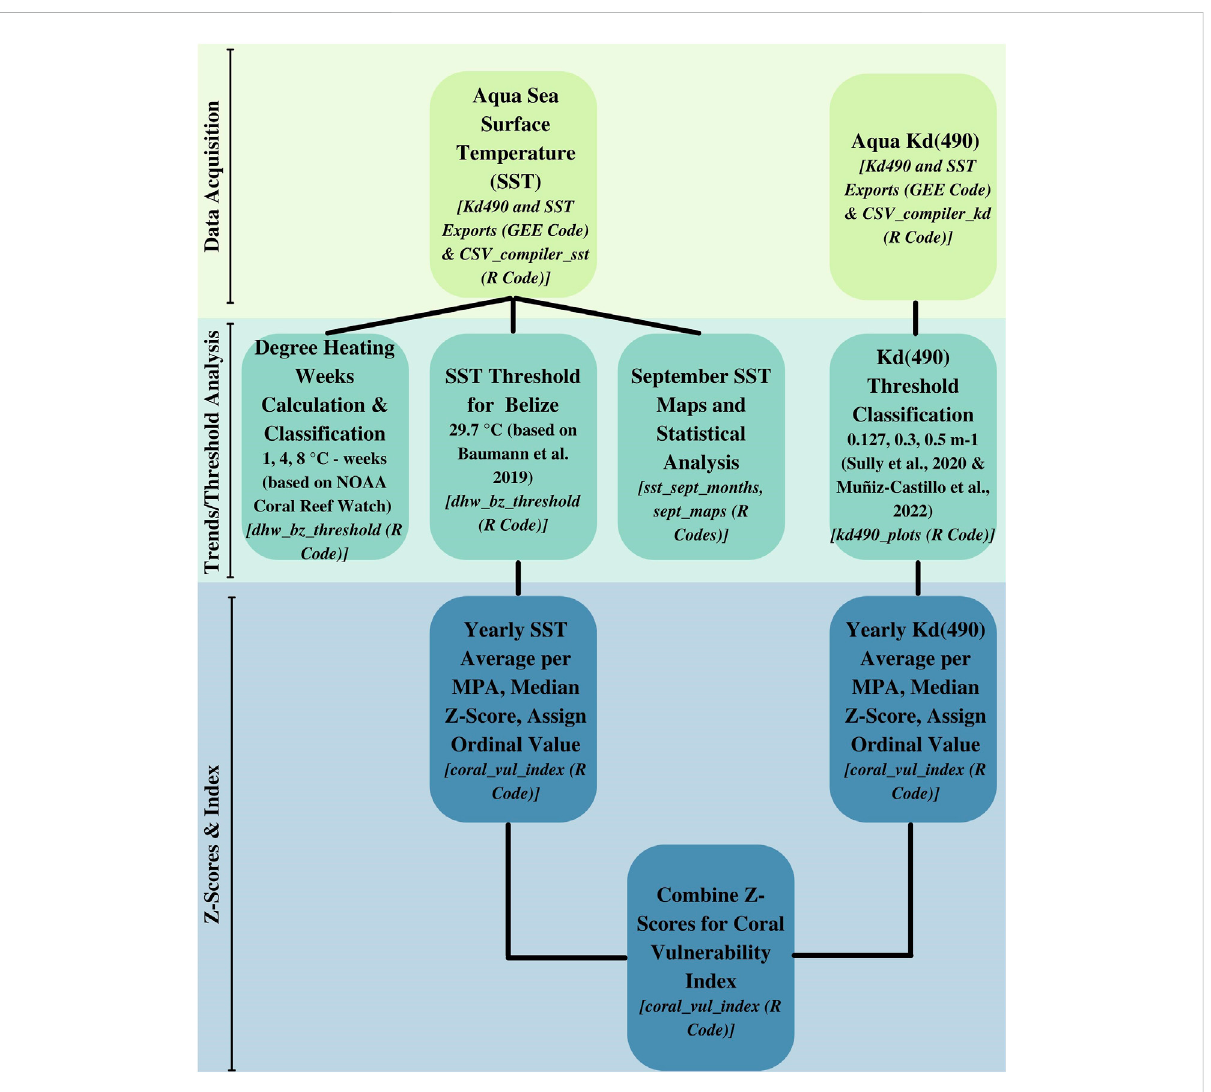
FIGURE 1 Schematic of work fl ow indicating data sources, processing steps, and fi nal